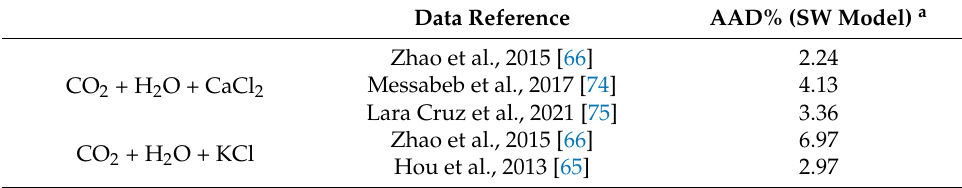
Figure 4. CO 2 solubility in different brines (NaCl, CaCl 2 , or KCl): comparison of predictions using SW EoS (solid lines) with literature data (symbols) [63,64,66–73]. Table 2. Deviation between experimental data and SW model prediction of CO 2 solubility in